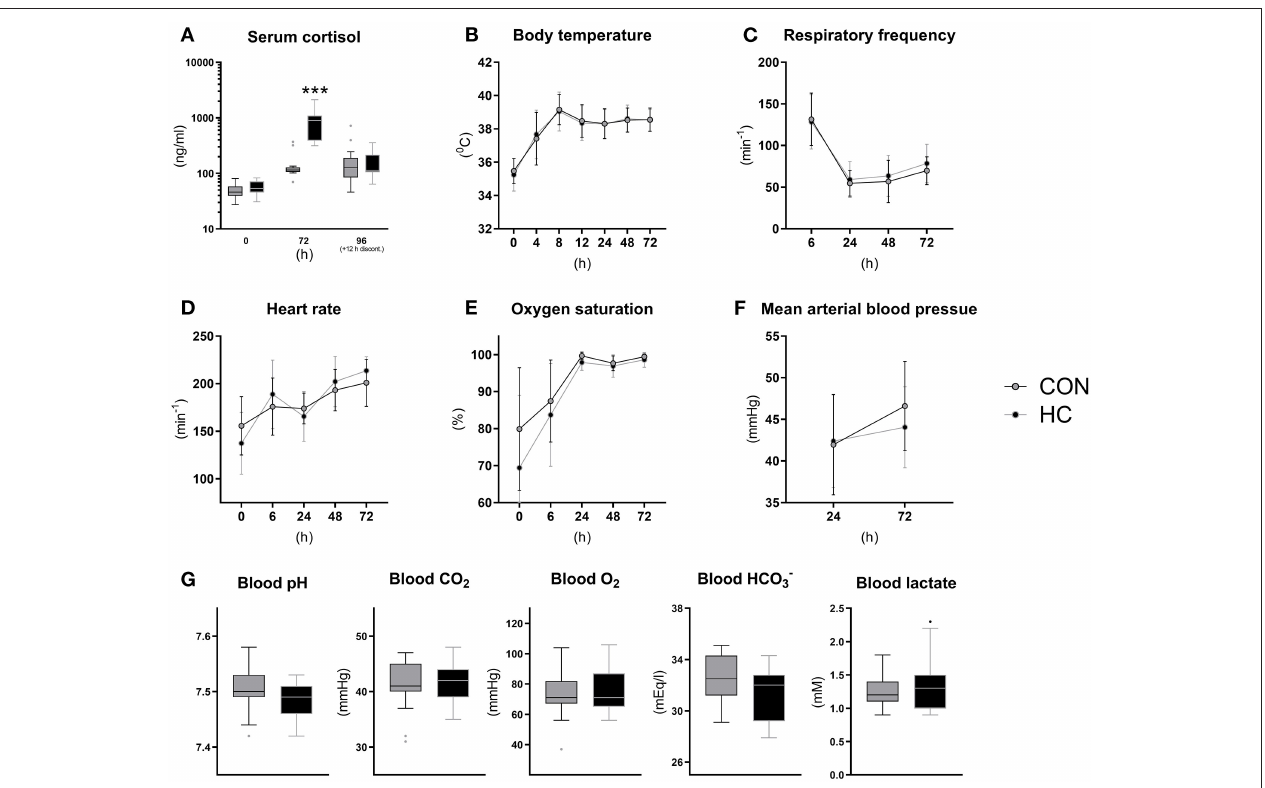
FIGURE 5 | Serum cortisol levels (A) , core body temperature (B) , pulmonary and cardiovascular functions (C–F) and arterial blood gas parameters at 24h (G) for hydrocortisone (HC) and control (CON) Preterm piglets. Longitudinal data is presented as means with standard deviations, and remaining data is presented as box plots (box edges denote interquartile ranges and horizontal line denotes the median value) with Tukey whiskers (outliers shown as dots). ***Denotes a probability value below